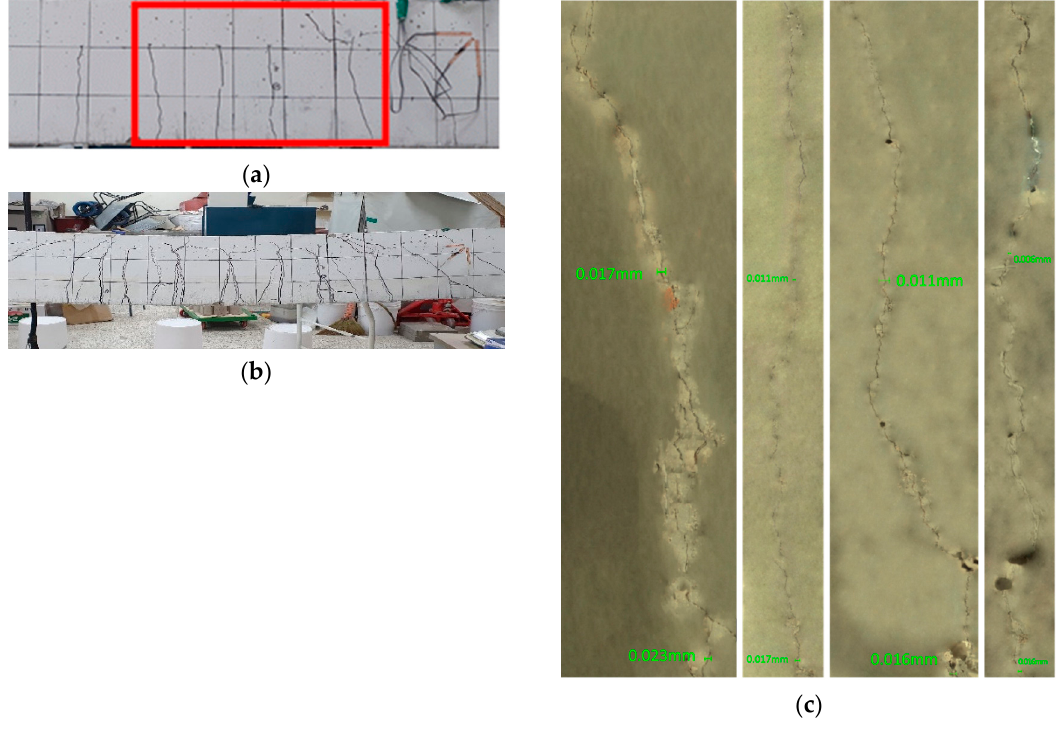
Figure 23. Crack healing of member RL_28 + 90D-0.85: ( a ) after pre-loading at 28 days + 90 days of additional curing; ( b ) after loading at 28 + 90 days; ( c ) enlargement of cracks after completion of test.